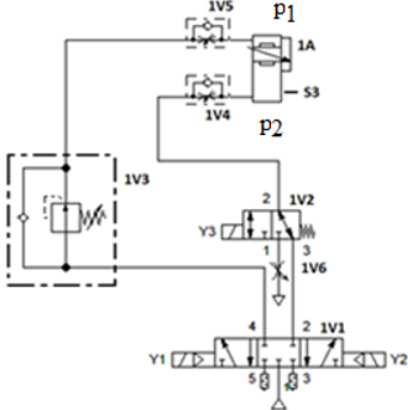
Fig. 10. Pneumatic